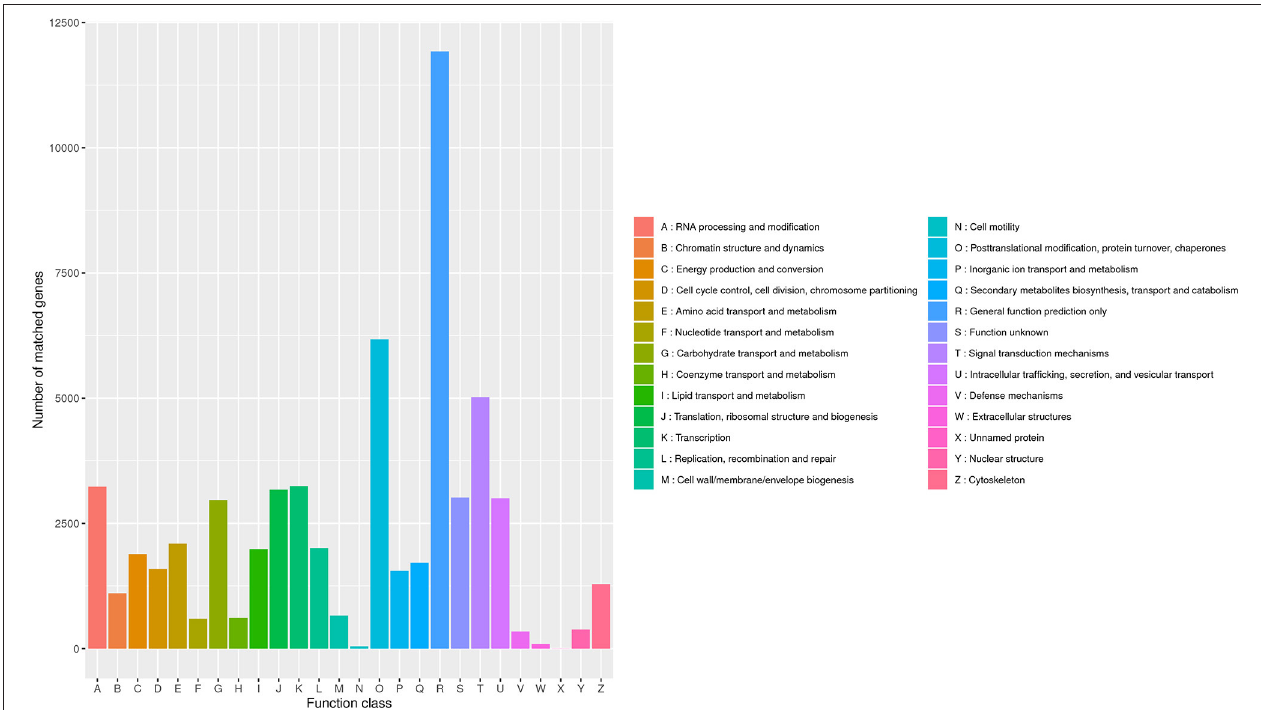
FIGURE 4 | Classification of B. striata in KOG. The transcripts could be roughly divided into 26 categories according to their function (represented by A-Z), and the number of genes in each category was counted.